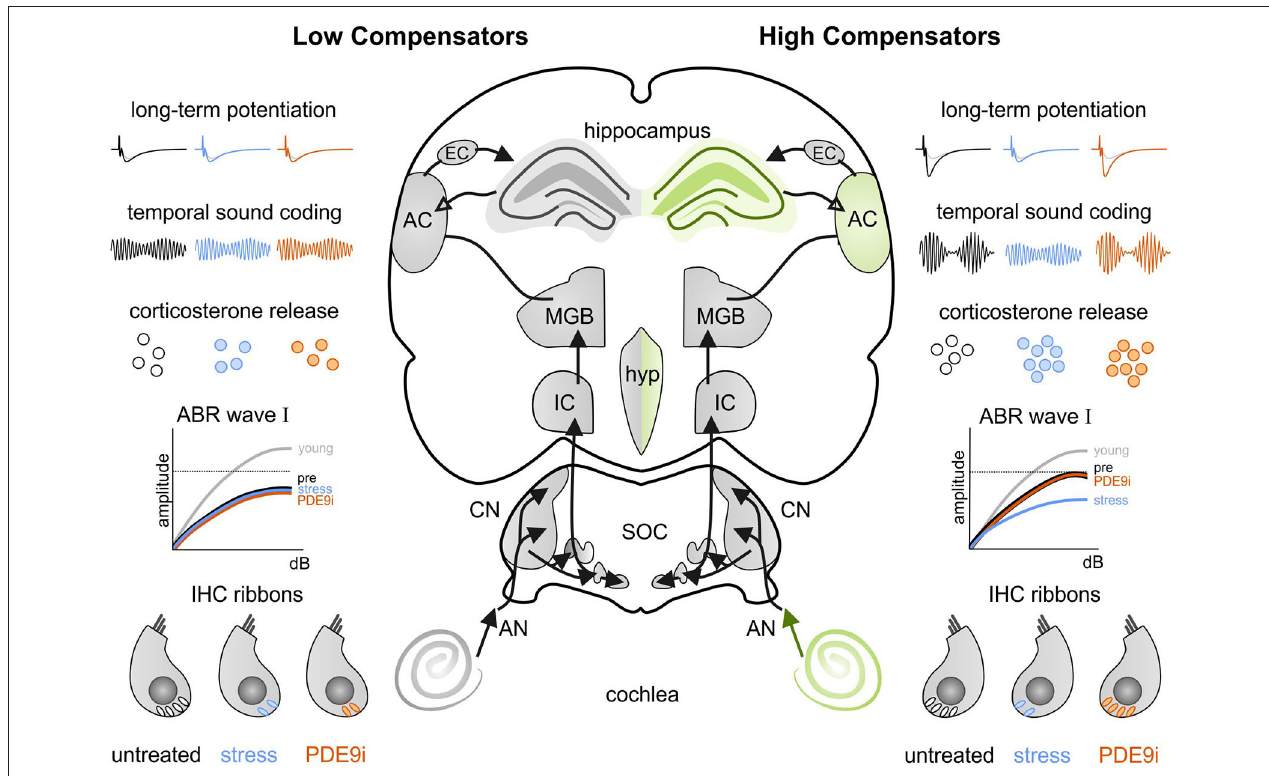
FIGURE 8 | An abstract scheme of the mechanisms in the auditory pathway that are differentially affected by stress or PDE9i application in low compensators (the left side) and high compensators (the right side). Low compensators have a lower baseline corticosterone level (black, left) in comparison to high compensators (black, right). When stress due to repeated injections is applied (blue/orange), high compensators respond in a physiological way, with increased corticosterone release. Low compensators, on the other hand, do not have increased corticosterone levels after application of a stressor, showing characteristics of a blunted stress response. This blunted stress response prevents low compensators from reacting to both a stress-induced drop of long-term potentiation, temporal sound coding, auditory nerve response (ABR wave I), and inner hair cell ribbons, which we see in high compensators. Additionally, where treatment with a PDE9i is able to preserve all of these parameters in high compensators, the blunted stress response of low compensators prevents their restoration. ABR, auditory brainstem response; AC, auditory cortex; AN, auditory nerve; CN, cochlear nucleus; dB, decibels; EC, entorhinal cortex; hyp, hypothalamus; IC, inferior colliculus; IHC, inner hair cell; MGB, medial geniculate body; SOC, superior olivary